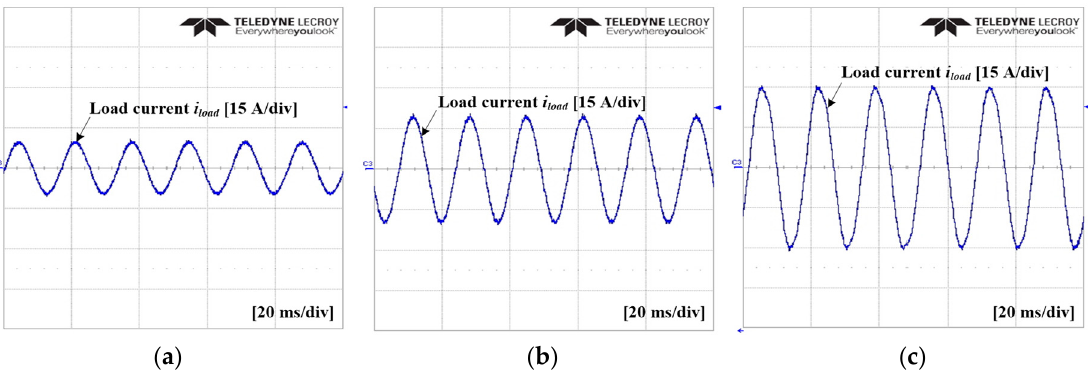
Figure 10. Experimental results for the amplitude control. ( a ) Amplitude: 10 A; ( b ) Amplitude: 20 A; ( c ) Amplitude: 30 A.